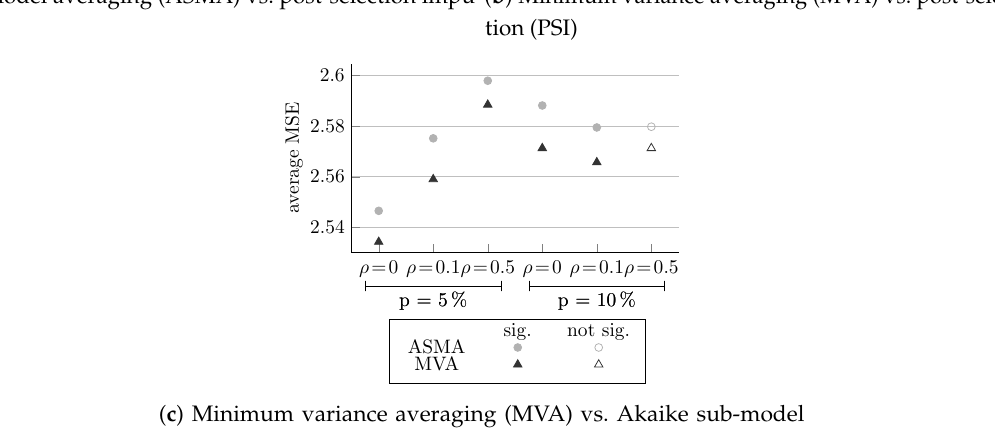
Figure 6. Comparing the MSE of the methods extending the normalized AIC to each other, averaged over 100 simulations, and the significance of the